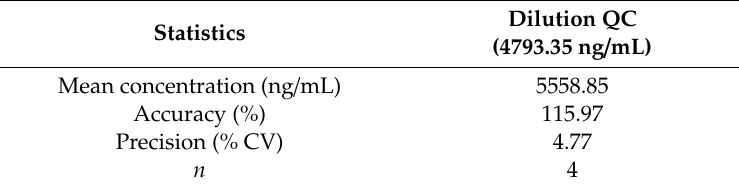
Table 2. The dilution integrity assessment in rat